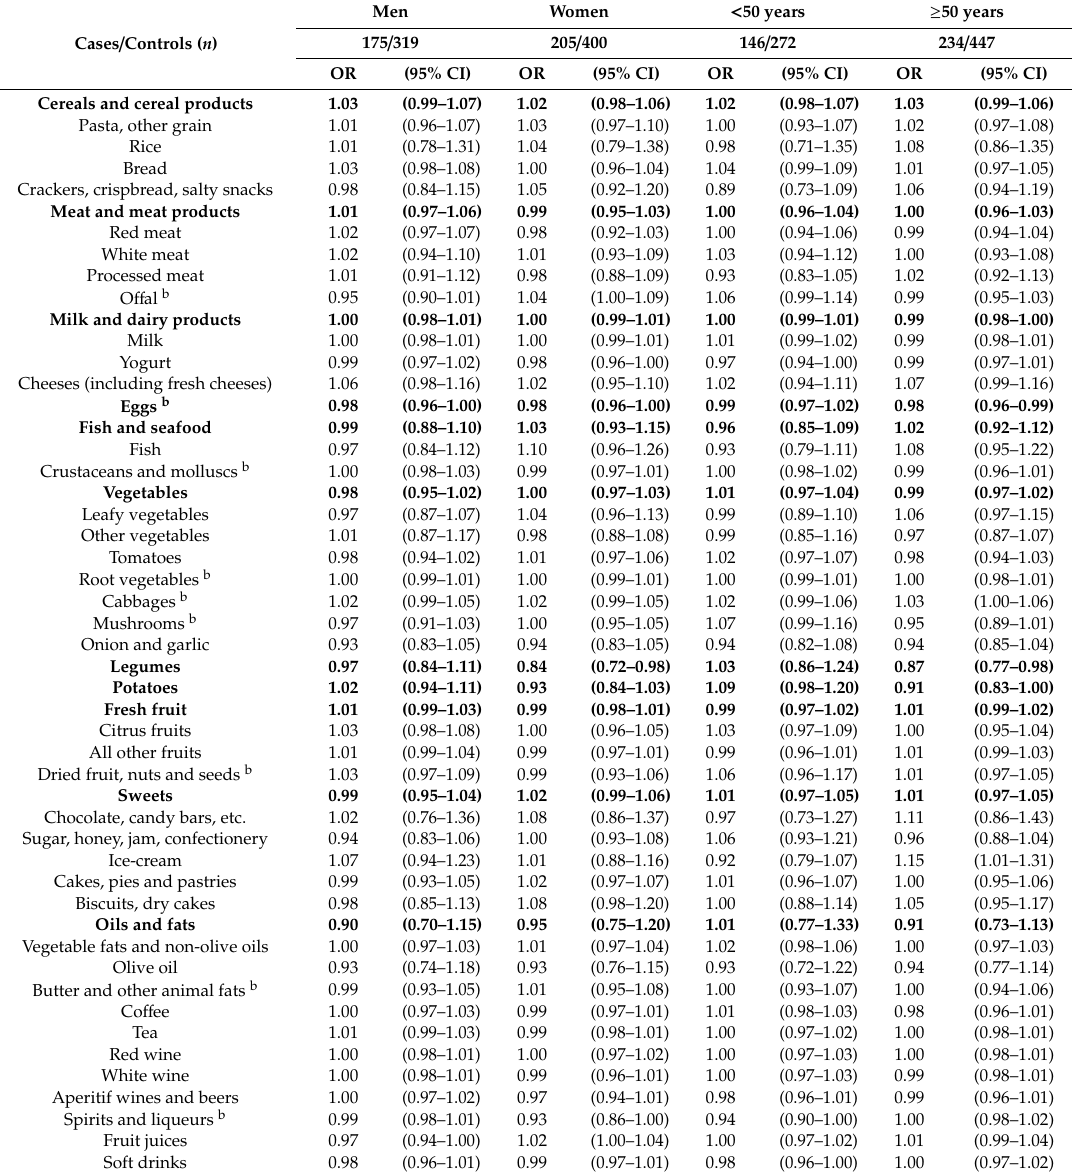
Table 4. Overall adjusted a odds ratios (OR) and 95% confidence intervals (CI) for developing cutaneous malignant melanoma associated to 10-g increments of daily intake (residual of regression on energy) according to sex or